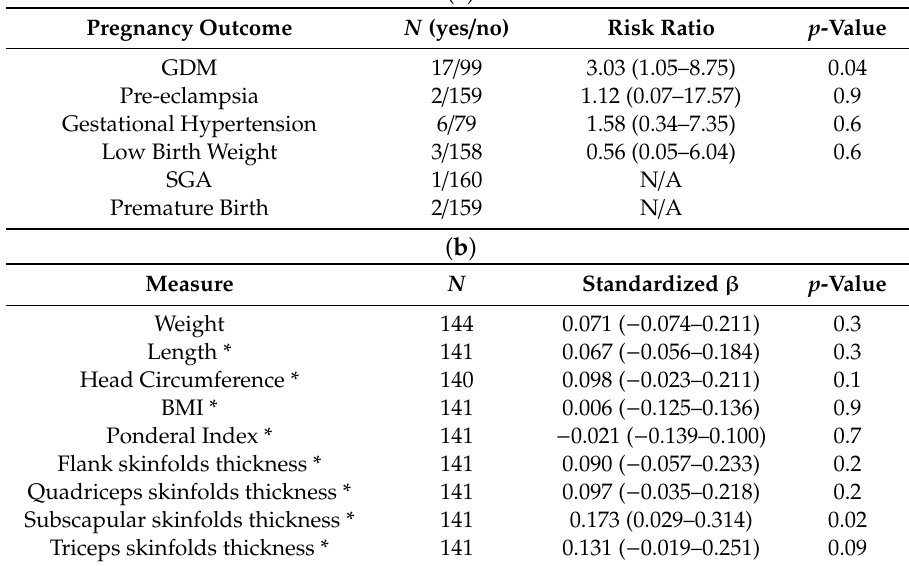
Table 5. Associations of micronutrient supplementation in pregnancy with ( a ) outcomes of pregnancy and ( b ) o ff spring size at birth and adiposity in women and babies where the mother was less than 30 years of